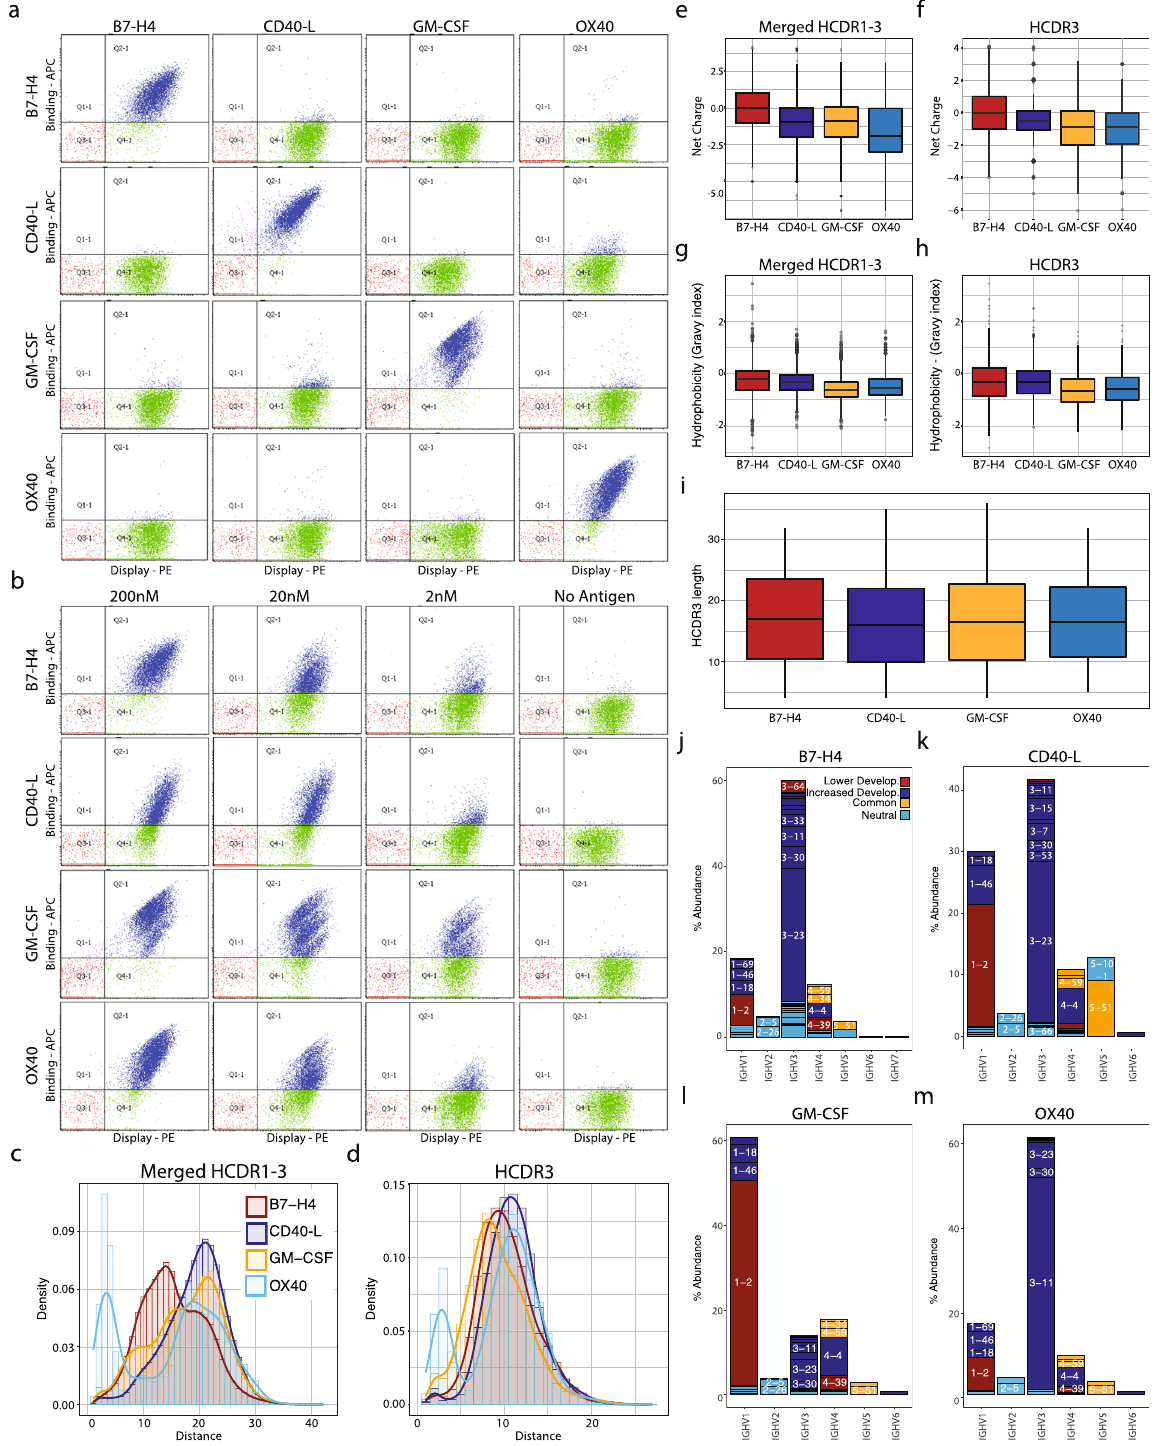
Fig. 6 Phage and yeast selection against four therapeutically relevant targets shows highly developable candidates and biased biophysical pro fi les. a Limited cross-reactivity of yeast scFv across the different panel of antigens at 200 nM. b Yeast scFv-display selection against a wide range 2 – 200 nM of antigen, shows minimal background (0 nM) with a noticeable population obtained from each selection campaign. c , d Pairwise Levenshtein distances distribution of the merged HCDR1 – 3 and HCDR3 amino acids. e , f HCDR3 and merged HCDR1 – 3 amino acid net charge tabulated using pH = 7 on Lehninger pK scale, showing the clear disparity of binders. g , h Gravy hydrophobicity index analysis of merged HCDR1 – 3 and HCDR3 amino acids. i HCDR3 length distribution across different antigens. j – m Analysis of the selected scaffold and their developability pro fi